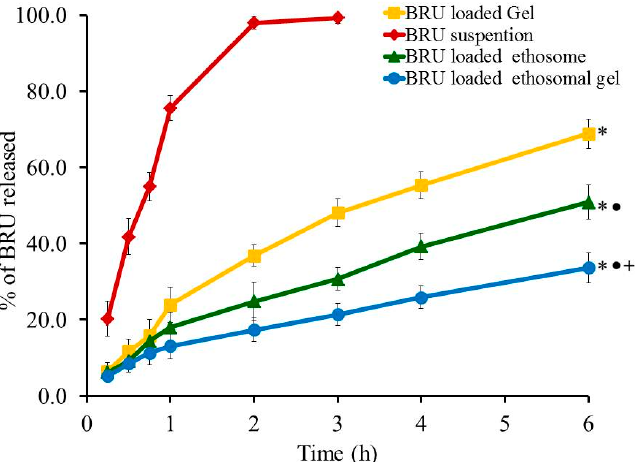
Figure 7. Profile of In vitro release experiment from BRU preparations at 37 ◦ C. Data are expressed as the mean ± SD ( n = 3). * p < 0.05 comparable to BRU suspension, • p < 0.05 comparable to BRU loaded gel and + p < 0.05 comparable to BRU loaded